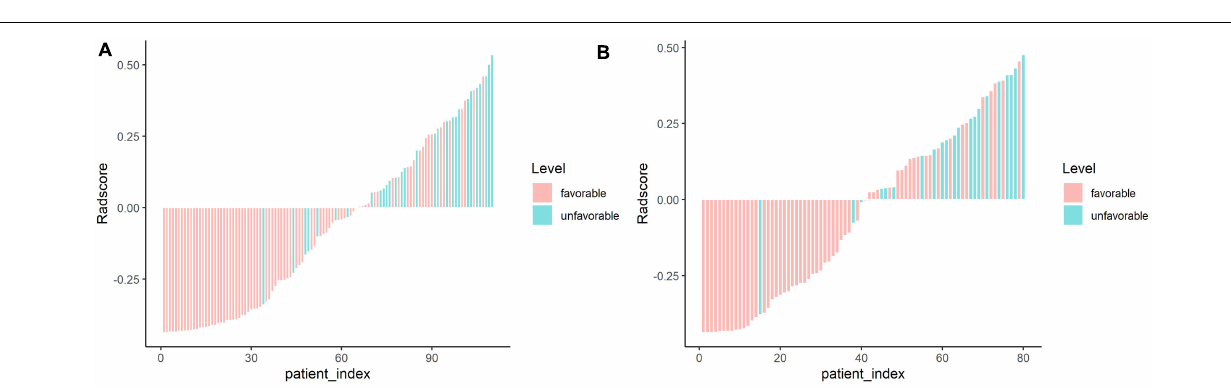
FIGURE 4 | Waterfall chart showing radscores for each patient in the training and validation sets. The red columns represent patients with favorable outcome, whereas the green columns represent those with unfavorable outcome. (A) Training set. (B) Validation